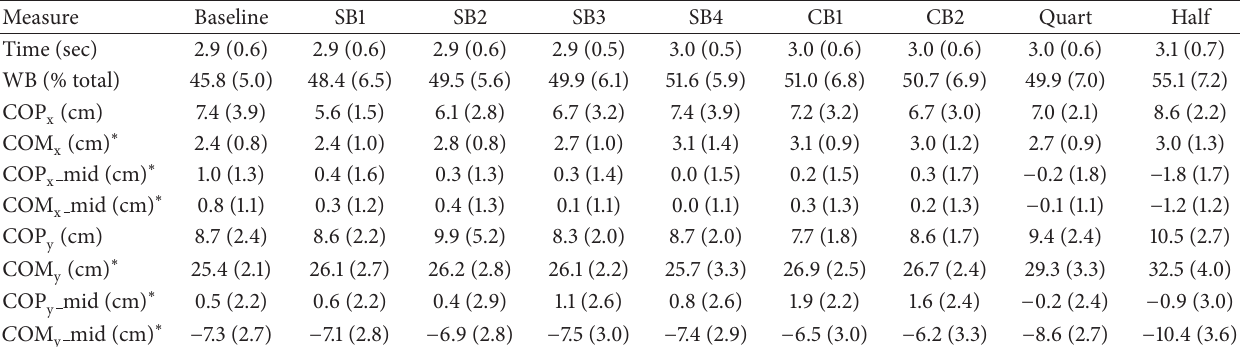
Table 2: Mean (SD) of all measures across all